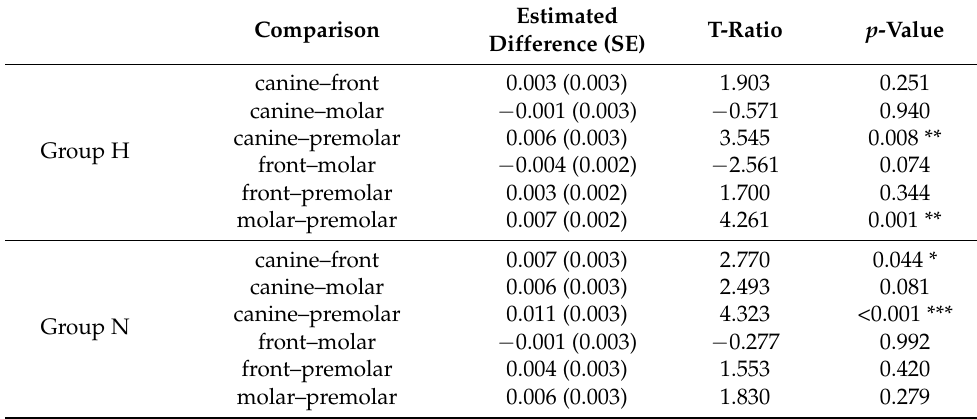
Table 3. Within-group comparison of local thickness values (mm) for group high (H) and narrow (N) aggregated for tooth type. Comparison was achieved using multiple comparison post hoc test with Tukey-method for p -value adjustment (family of 4 estimates), respectively. * p < 0.05, ** p < 0.01, *** p < 0.001.